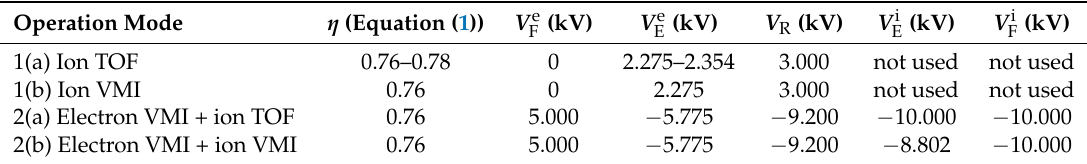
Table 1. Simulated optimum voltages for the different operation modes. For Mode 1(a), the exact optimum voltage V e depends on the initial velocity of the E